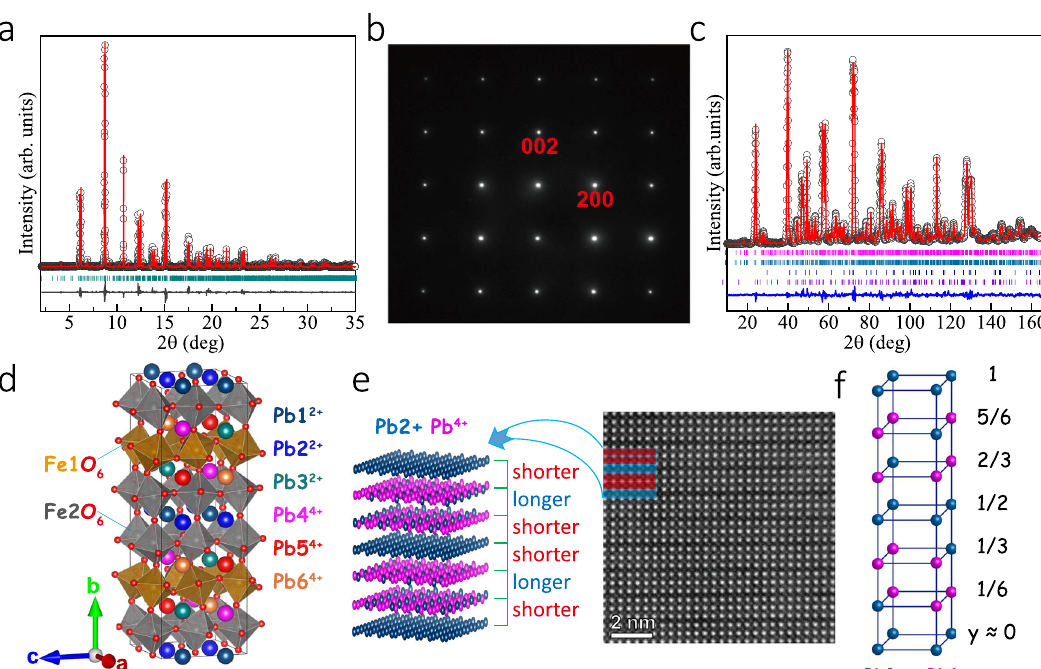
Fig. 1 Synthesis and crystal structure characterizations of PbFeO 3 . a Rietveld re fi nement for SXRD pattern recorded at room temperature for PbFeO 3 . Observed (black circles), calculated (red line), and difference (gray line) values are shown. The allowed Bragg positions in Cmcm symmetry are indicated by ticks (dark cyan). b ED patterns along [010] pseudocubic zone axis at RT. c Rieveld re fi nement for NPD pattern at 300 K for PbFeO 3 . Observed (black circles), calculated (red line), and difference (blue) values are shown. Bragg positions of PbFeO 3 are indicated by ticks (dark cyan), which correspond to the allowed nuclear (magenta) and magnetic (dark cyan) Bragg peaks of PbFeO 3 ; and allowed nuclear (navy) and magnetic (violet) Bragg re fl ections of the impurity phase Fe 2 O 3 (~5 wt%). d Crystal structure of PbFeO 3 . e Left part: illustration of Pb modulations; Right part: HAADF image along [001] pseudocubic zone axis of PbFeO 3 . Distances for the bright spots, which are the locations of Pb, indicate a modulation with a shorter – longer – shorter pattern. f Sketch of unique -A-B-B- type of charge ordering of PbFeO 3 composed of two types of differently charged layers.